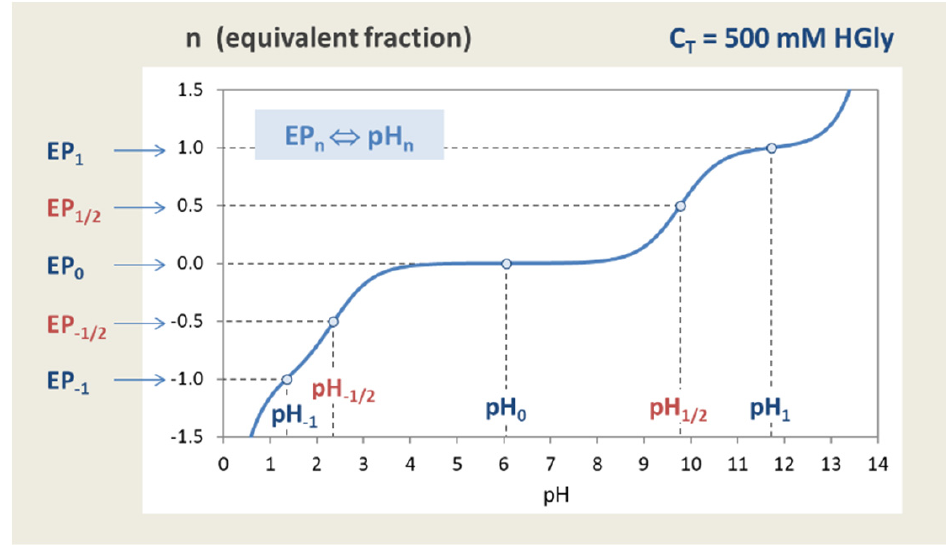
Figure 40. Titration curve of glycine with EPs and semi-EPs located at integer and half-integer n.